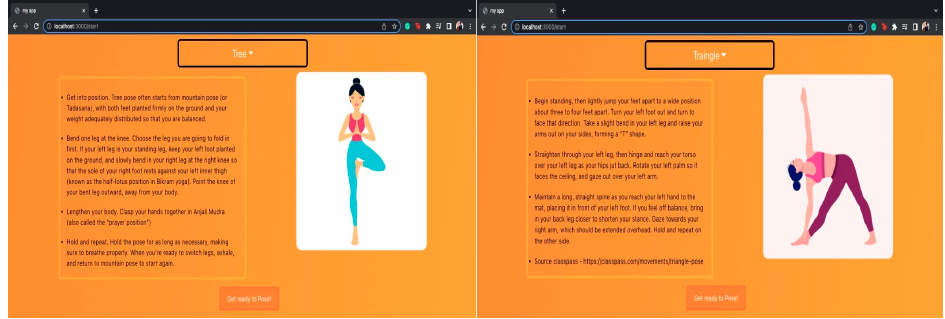
Figure 12. Tree posture and Triangle posture along with a proper guide on how to perform them.